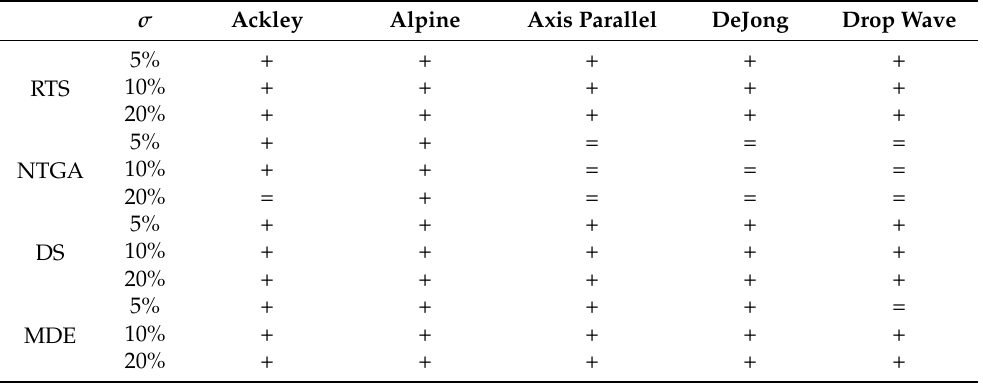
Table 7. Results of non-paired t -tests with a confidence level of 95%, comparing N-RTS against other algorithms by using the benchmark functions of Table 6 with different noise